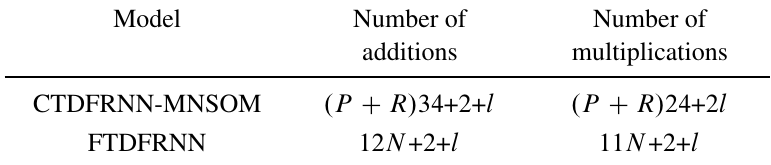
Table 6. Computational complexity of FNS based design compared to temporal- MLP and RNN-based architectures with N length filter (for temporal MLP struc- tures) or delay blocks (for RNN-based structures), n number of parallel structures, l size competitive layer and .P C R/ length of the